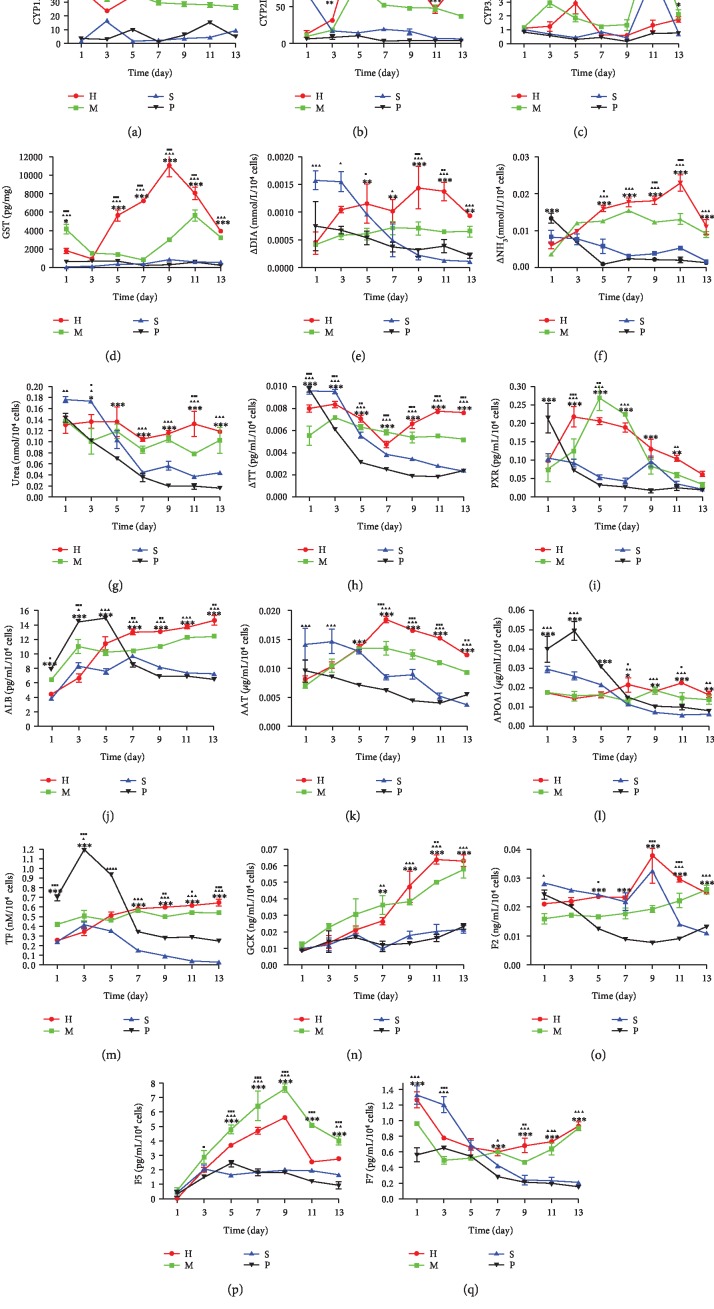
Dynamic testing of hepatocyte function: comparison of CYP1A2 synthesis (a), CYP2A6 synthesis (b), CYP3A4 synthesis (c), glutathione-S-transferase (GST) synthesis (d), diazepam (DIA) synthesis (e); ammonia (NH3) metabolism (f); urea synthesis (g), testosterone (TT) metabolism (h), and pregnane X receptor (PXR) synthesis (i), albumin (ALB) synthesis (j), α1-antitrypsin (AAT) synthesis (k), apolipoprotein A1 (APOA1) synthesis (l), transferrin (TF) synthesis (m), glucokinase (GCK) synthesis (n), Factor II (F2) synthesis (o), Factor V (F5) synthesis (P), and Factor VII (F7) synthesis (q). Comparison of the data are presented as mean ± SD. Two-way ANOVA: H vs. P: ∗P < 0.05, ∗∗P < 0.01, ∗∗∗P < 0.001; H vs. S: ▲P < 0.05, ▲▲P < 0.01, ▲▲▲P < 0.001; H vs. M: ■P < 0.05, ■■P < 0.01, ■■■P < 0.001. H: hepatic plate-mimetic group; M: mixed 3D group; S: sandwich group; P: mixed 2D/plate group.